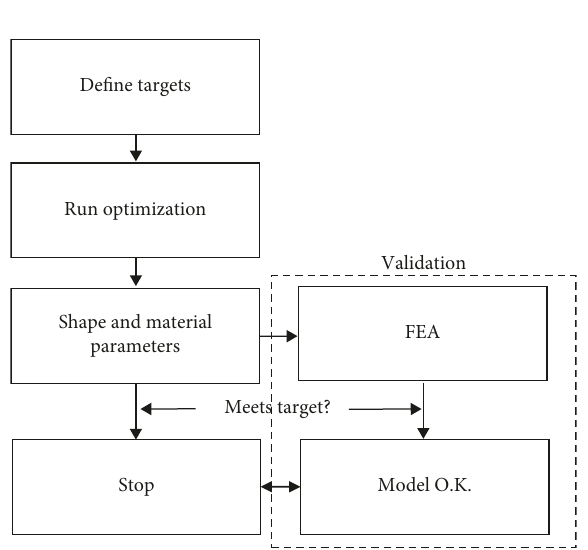
Figure 9: Block diagram of the validation procedure using FEA- based